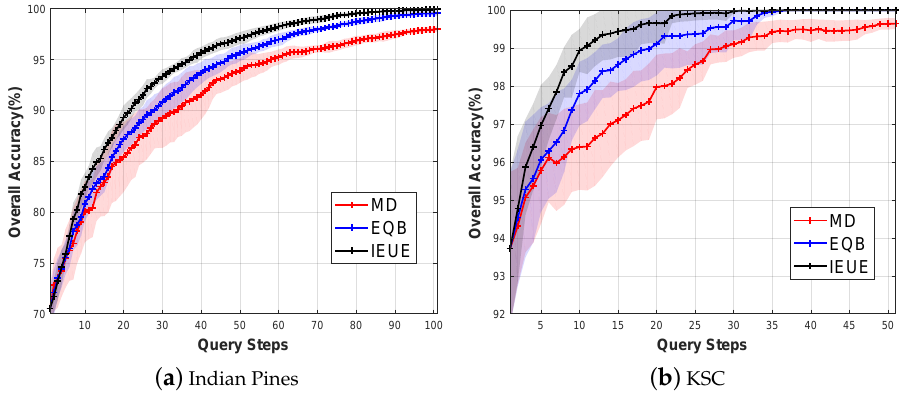
Figure 11. Learning curves (i.e., OA and standard deviation versus the query steps) of different query selection methods for ( a ) Indian Pines and ( b )